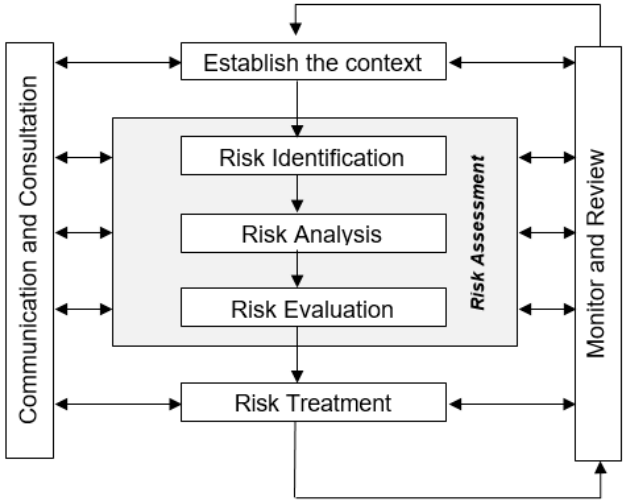
Figure 1. The Risk Management Process from ISO. Source: author own study on ISO 31000 (2009).